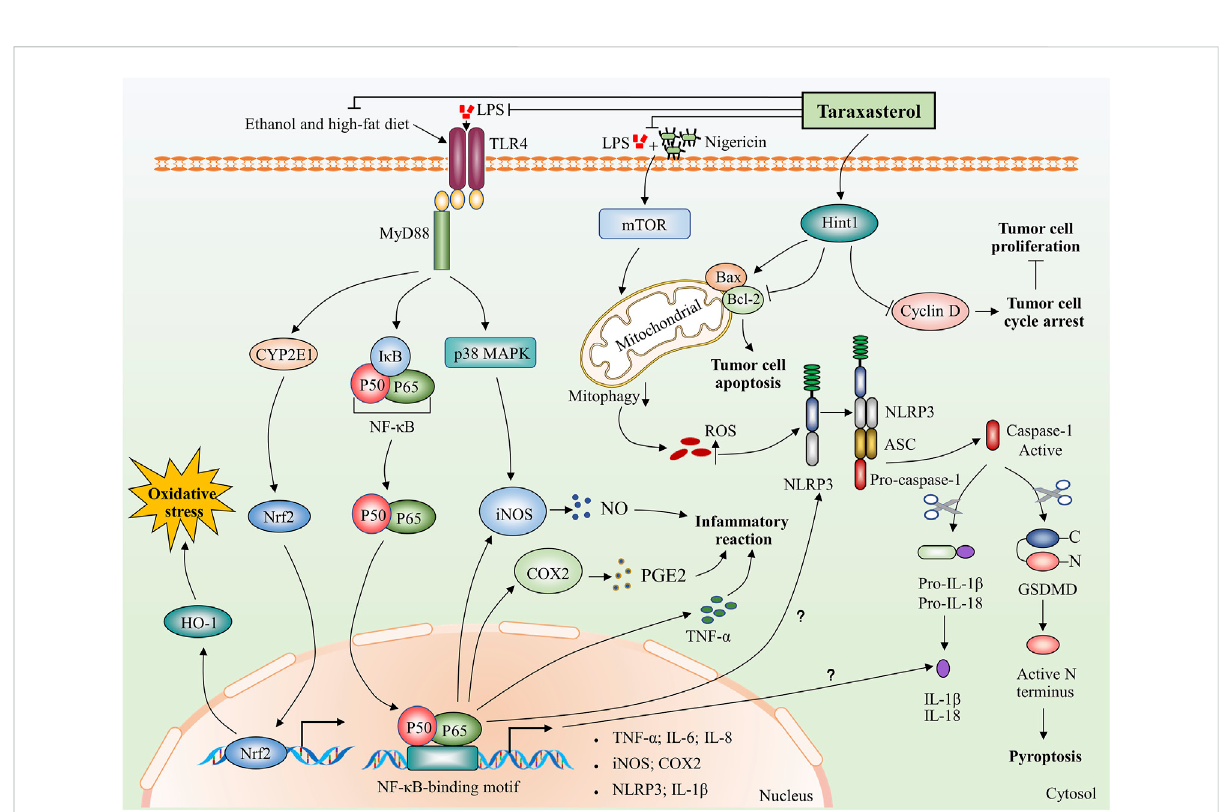
FIGURE 2 Potential biologicalmechanismsoftaraxasterol: anti-in fl ammatory,anti-oxidative,andanti-carcinogenic. Taraxasterol impacts several aspects of in fl ammatory action. On the one hand, taraxasterol reduces the levels of in fl ammatory cytokines, including TNF- α and IL-6 and reduces serum levels of in fl ammatory mediators NO and PGE ₂ through inhibiting NF- κ B and MAPK signaling pathways. On the other hand, taraxasterol reduces ROS-mediated NLRP3 in fl ammation activation by suppressing mTOR and mitophagy, which contributes to the reduction of the in fl ammation reaction. Interestingly, NF- κ B also regulates the expression of NLRP3 and IL-1 β at transcriptional levels, yet the underlying mechanisms of whether the taraxasterol alleviates NLRP3 in fl ammation activation and reduces the levels of IL-1 β by inhibiting the NF- κ B signaling pathway are unclear. In addition, taraxasterol reduces oxidative stress induced by ethanol and a high-fat diet by inhibiting the expression of transcription factor Nrf2. Taraxasterol can promote tumor cell apoptosis and inhibit tumor cell proliferation by upregulating Hint1 expression in human liver